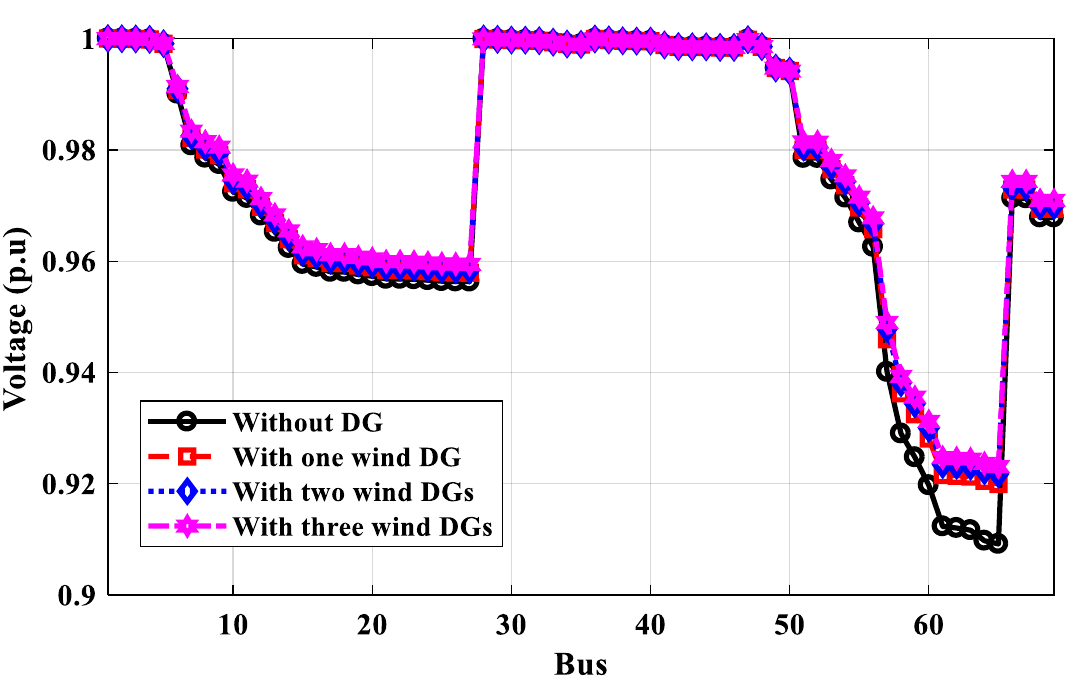
Figure 18. Voltage profile of IEEE 69-bus without and with wind farm DGs for annual energy loss calculation.